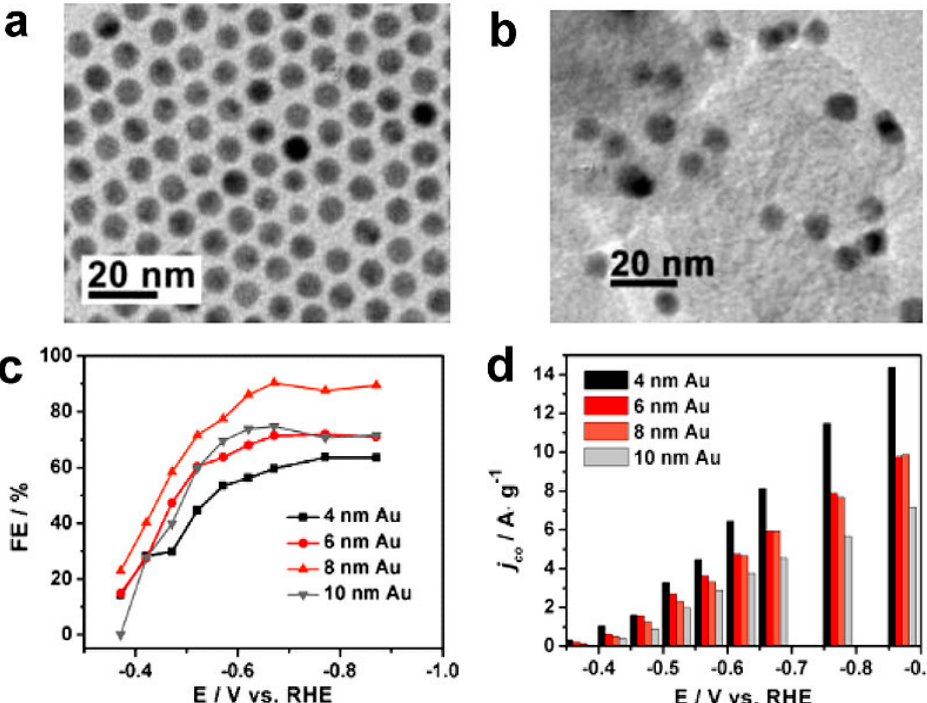
Figure 3. TEM images of ( a ) the 8 nm Au NPs and ( b ) the C-Au NPs (embedded in carbon matrix). ( c ) Potential-dependent FEs of the C-Au on electrocatalytic reduction of CO 2 to CO. ( d ) Current densities for CO formation (mass activities) on the C-Au at various potentials. Reprinted (adapted) with permission from [13]. Copyright 2013 American Chemical